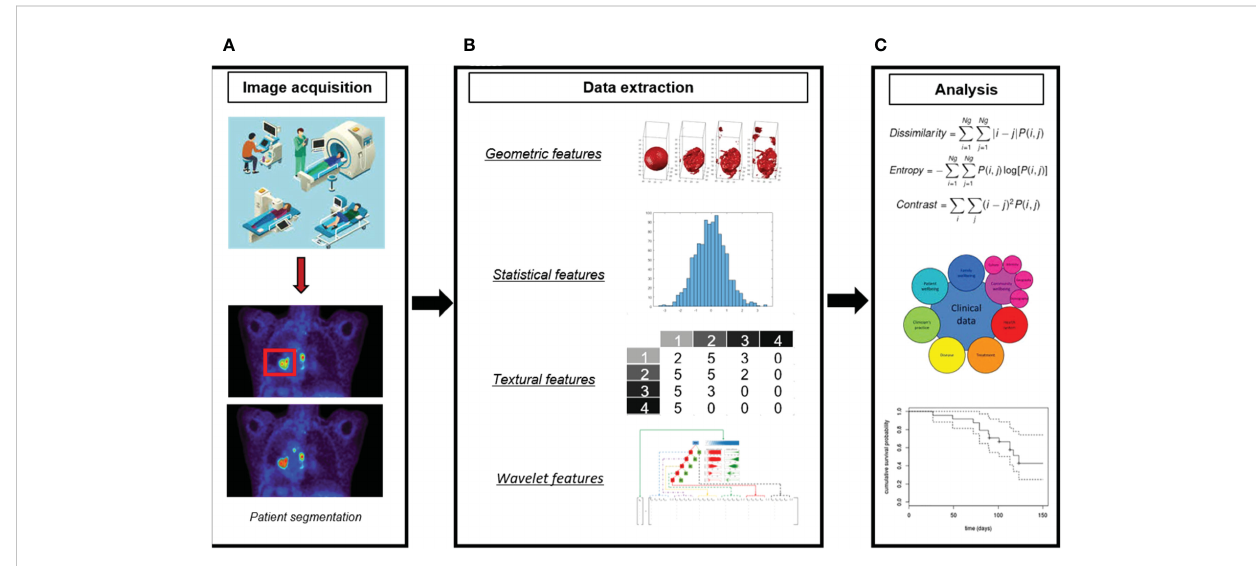
FIGURE 1 A work fl ow of radiomics analysis (18). (A) Image acquisition and ROI segmentation. (B) Extraction of radiomic features. (C) Model